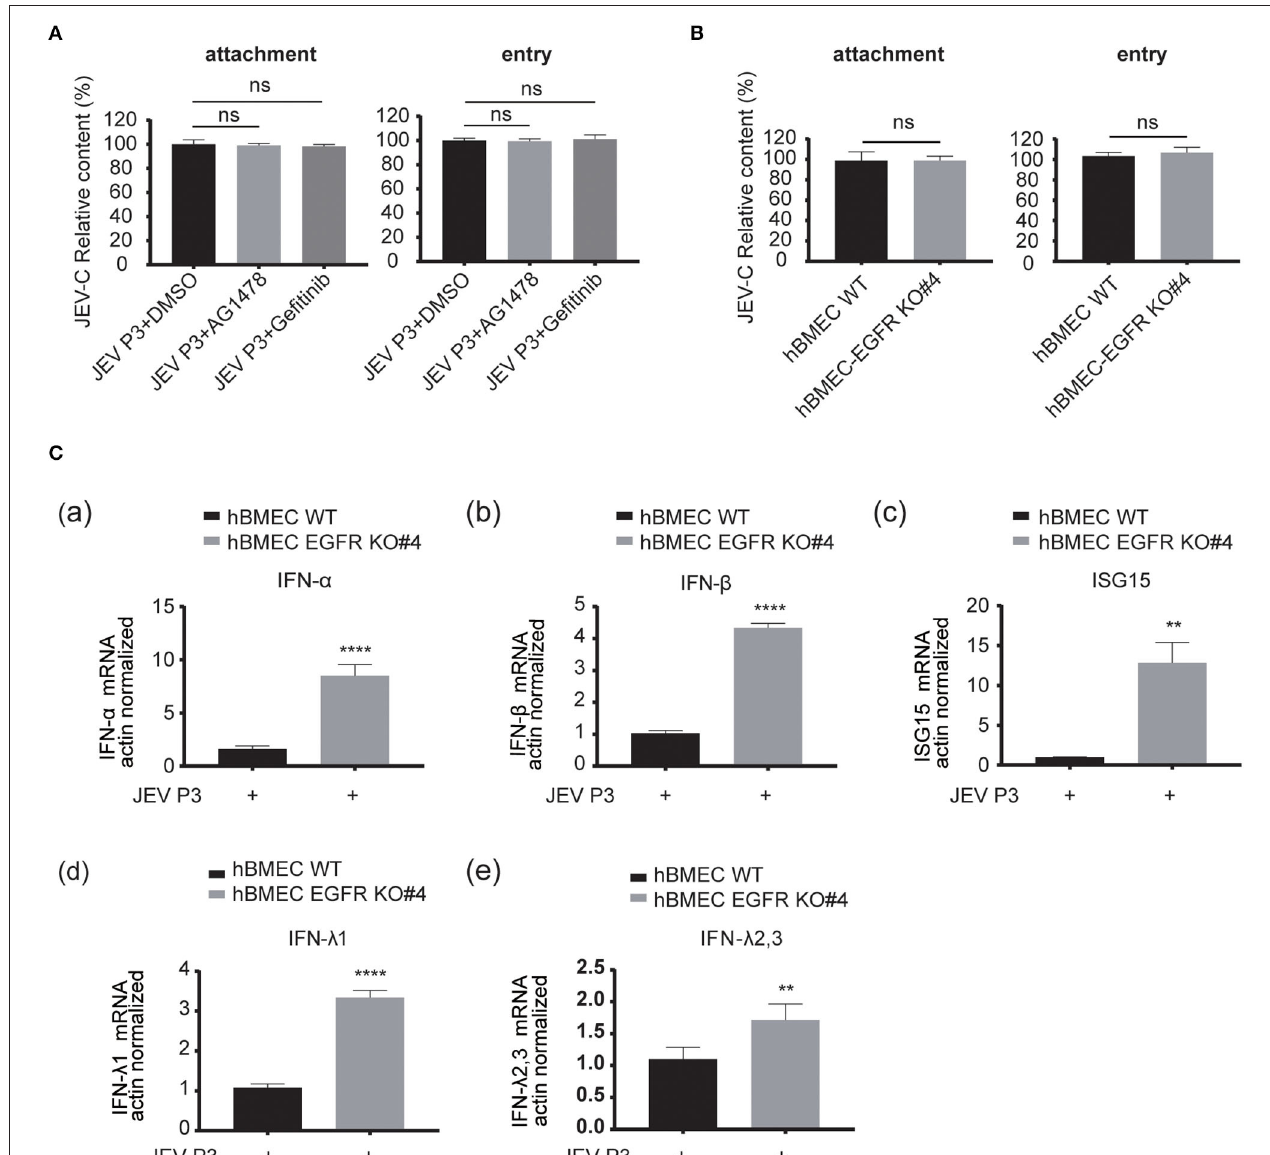
FIGURE 5 | EGFR is involved in the antiviral response of interferon signaling. (A) The hBMECs were treated with AG1478, gefitinib, or vehicle control DMSO, and then bound with JEV P3 (MOI = 10) at 4 ◦ C for 1h for attachment. The cells were transferred to a 37 ◦ C incubator for 1h for entry, and total RNA was extracted to determine the RNA copy numbers of JEV P3 with quantitative real-time PCR. (B) The hBMECs and EGFR-KO hBMECs were infected with JEV P3 (MOI = 10) at 4 ◦ C for 1h. After washing thrice with PBS containing proteinase k, the cells were then transferred to a 37 ◦ C incubator for 1h to allow virus entry. (C) Comparison between hBMECs and EGFR-KO hBMECs in mRNA levels of IFN (IFN- α , IFN- β , IFN- λ 1, and IFN- λ 2, 3) and ISG15 production in the presence or absence of JEV P3 infection. The hBMECs and EGFR-KO hBMECs were infected with JEV P3 (MOI = 1) for 8h, and total RNA was extracted and quantitative real-time PCR was performed. The results are represented as mean ± SEM values from three independent experiments. **, p < 0.01; ****, p < 0.0001; ns, not